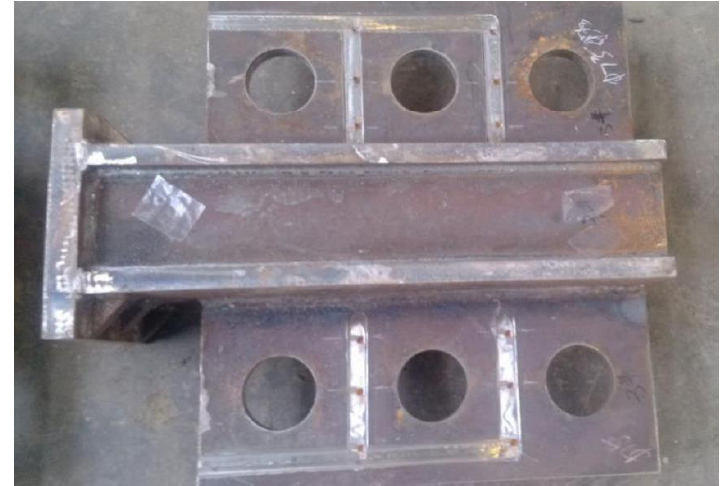
Figure 4. Test apparatus.